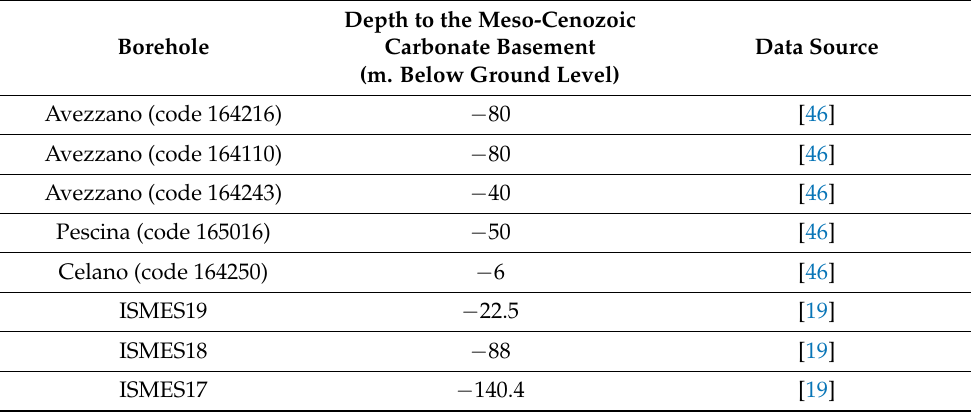
Table 1. Boreholes used to constrain the gravity